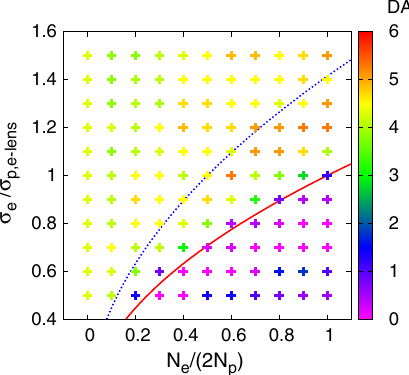
FIG. 14. Dynamic apertures in a 2D scan of the electron beam intensity and beam size. The proton bunch intensity is 2 : 5 (cid:2) 10 11 . The blue and red curves represent half and full beam-beam compensation, respectively.